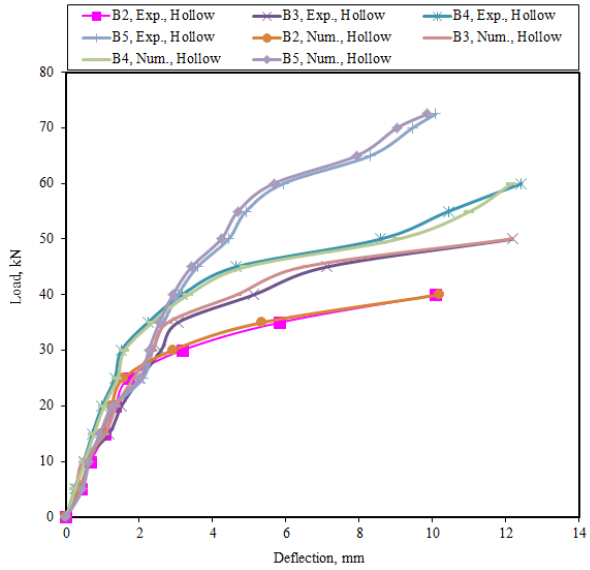
Figure 20. Experimental and numerical load versus mid-span deflection curves of the hollow RC beams (circle and rectangular).